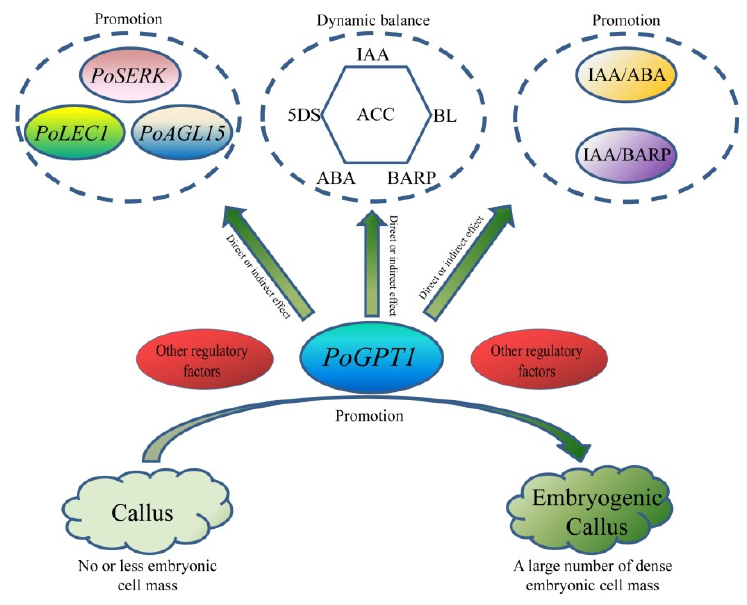
Figure 9. Model map of PoGPT1 promotion of embryogenic callus formation in tree peony ( Paeonia ostii ).